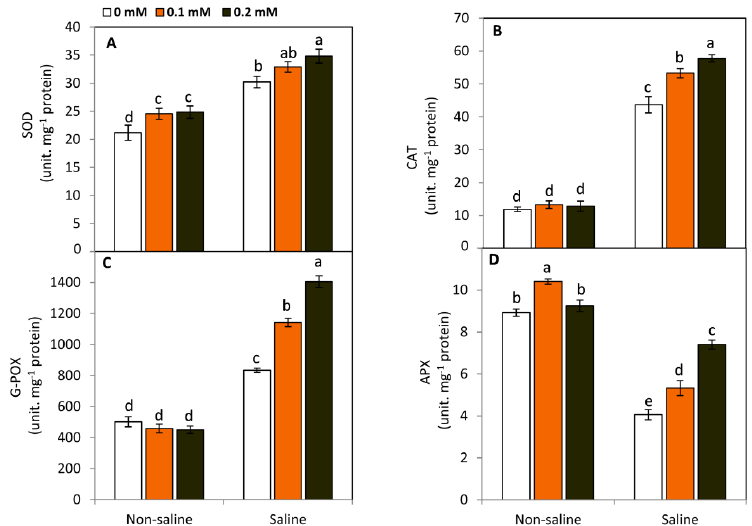
Figure 4. Effect of exogenous folic acid (FA; 0, 0.1, and 0.2 mM) on the activities of antioxidant enzymes including superoxide dismutase, SOD ( A ), catalase, CAT ( B ), guaiacol peroxidase, G-POX ( C ), and ascorbate peroxidase, APX ( D ), of snap bean plants grown under non-stressed and saline-stressed (50 mM, NaCl) conditions. Values are the averages of three replicates ± SD. Different letters indicate significant differences according to Duncan’s multiple range tests ( p < 0.05).